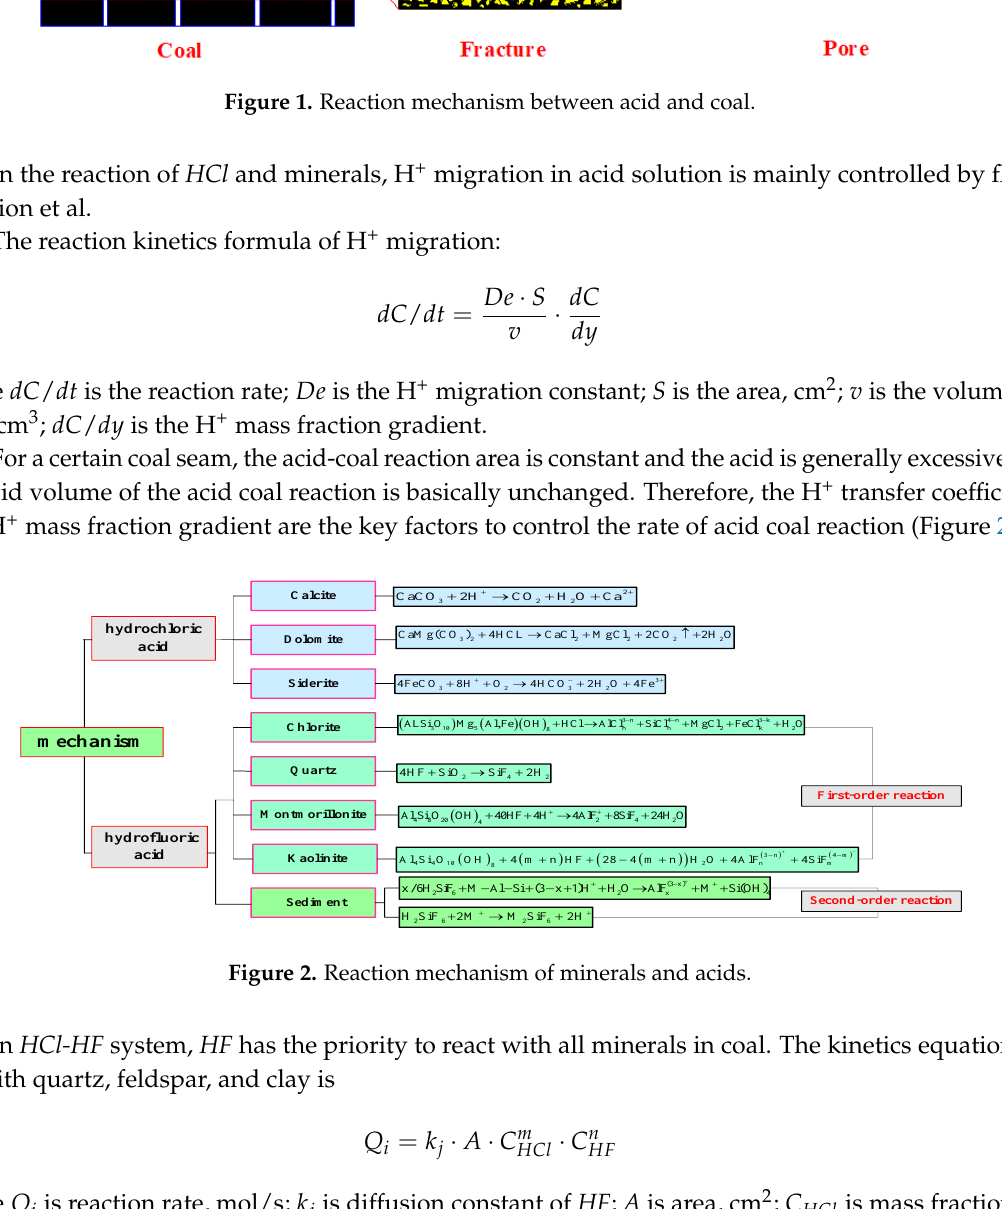
Figure 2. Reaction mechanism of minerals and acids.